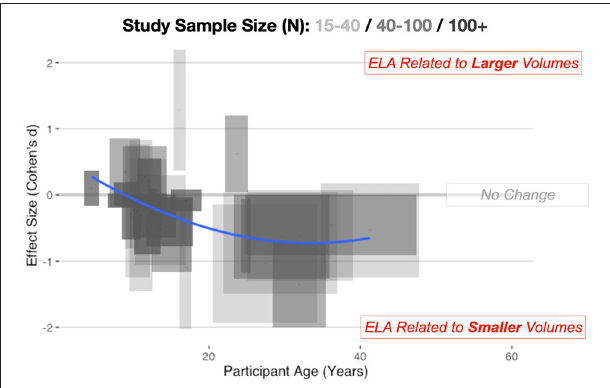
FIGURE 1 | Combining across automated and manual methods for quantifying the amygdala, here we depict amygdala volumetric differences for ELA-exposed samples. Cohen’s d, with 95% confidence intervals (CIs) of effects, are shown on the vertical axis, while the span in age is shown on the horizontal axis. Longer boxes (on the horizontal axis) indicate studies with larger age-ranges in their samples, while wider boxes (on the vertical axis) depict studies where the effect size estimates and 95% CIs span a larger numeric range. Study sample size is also depicted in this graphic with lighter boxes being studies with smaller sample sizes and darker boxes representing studies with a larger number of participants. Individual study data is available online at: https://github.com/jlhanson5/